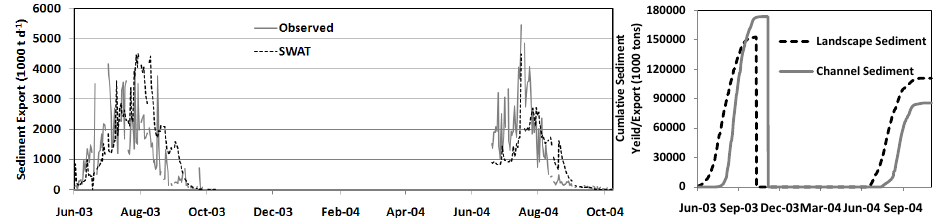
Fig. 9. Observed and SWAT modeled sediment export at the Sudan/Ethiopia border (a) and the predicted landscape sediment yield and channel sediment export (b) .